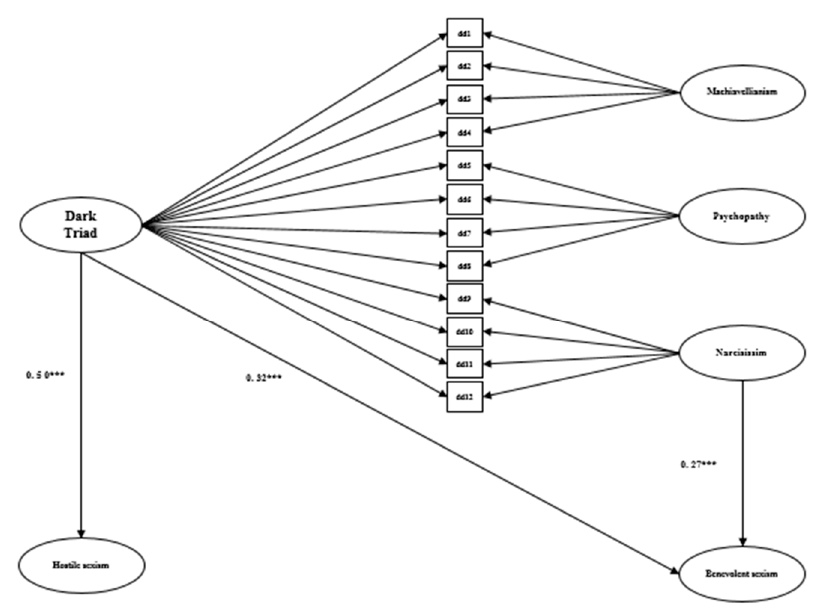
Figure 1. Standardized coefficients of regression statistically significant at p < 0.05 between Dark Triad and Ambivalent sexism in males. *** p < 0.001.